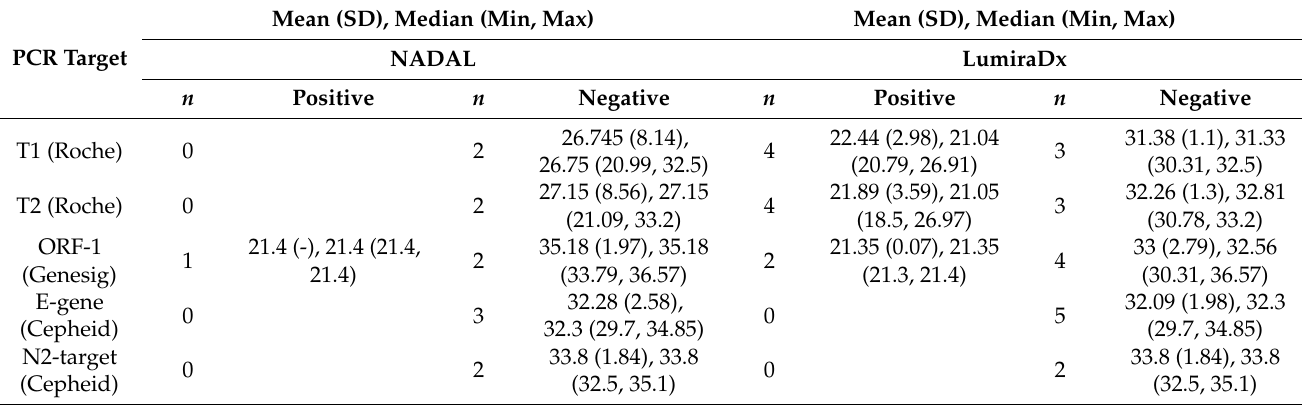
Table 2. Assessment of the matching of positive and negative tests with PCR Ct values.